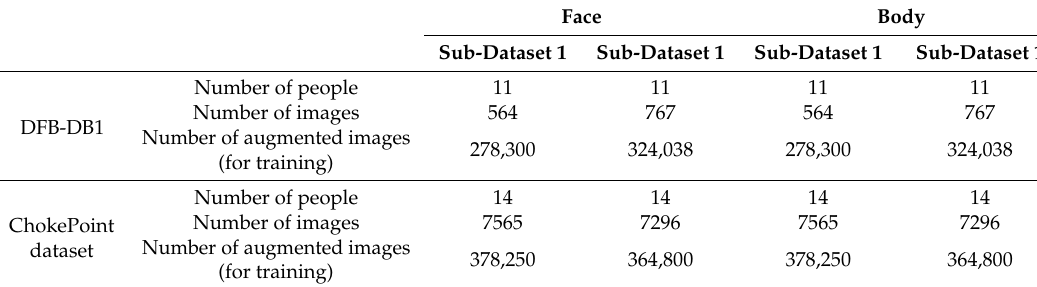
Figure 11. ChokePoint dataset image example. Table 4. Descriptions of DFB-DB1 and ChokePoint dataset.